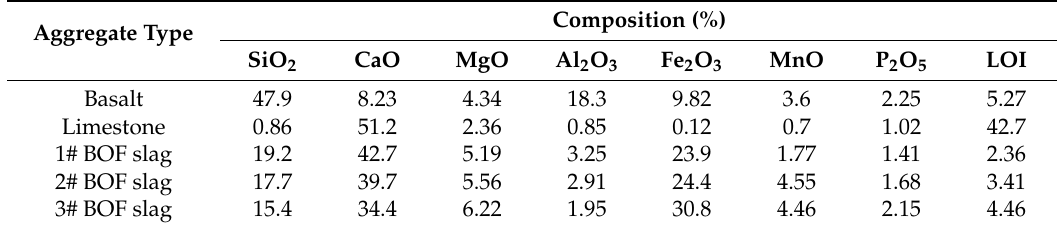
Table 1. Chemical composition of the aggregates.